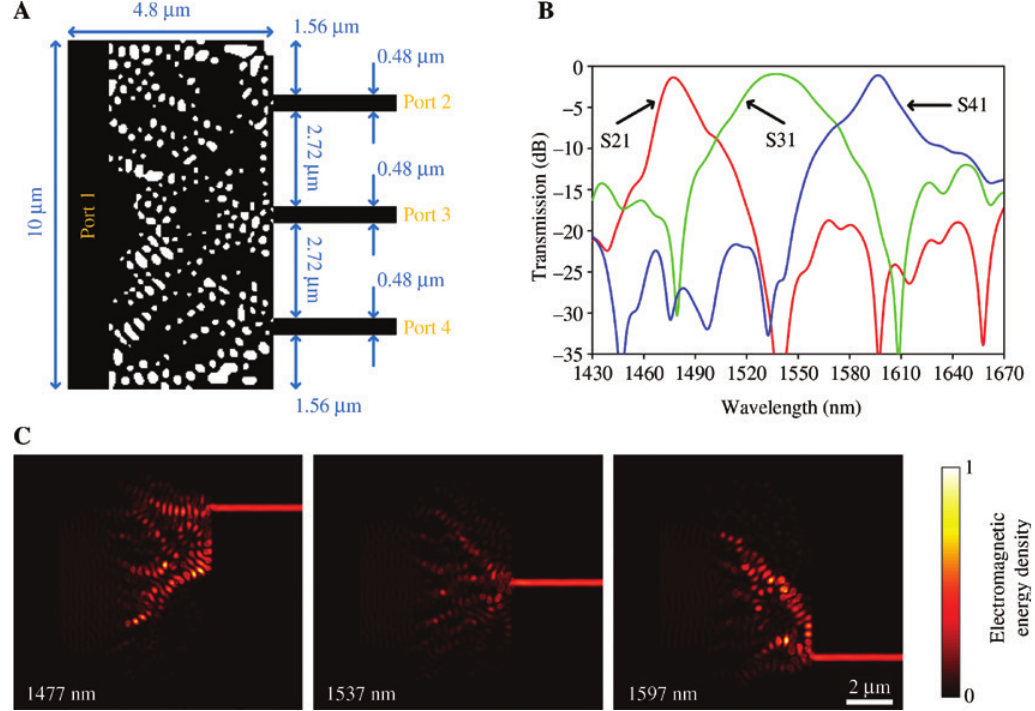
Figure 6: Three-channel focused wavelength demultiplexer with minimum feature size R = 3. (A) Structures of the designed demultiplexer, where black represents silicon and white represents air. The length (width) of the demultiplexer is 4.8 μ m (10 μ m). (B) Simulated S-parameters for the demultiplexer, where S (C) Simulated electromagnetic energy density in a horizontal slice through the middle of the demultiplexer, the wavelengths are 1477 nm, 1537 nm and 1597 nm,